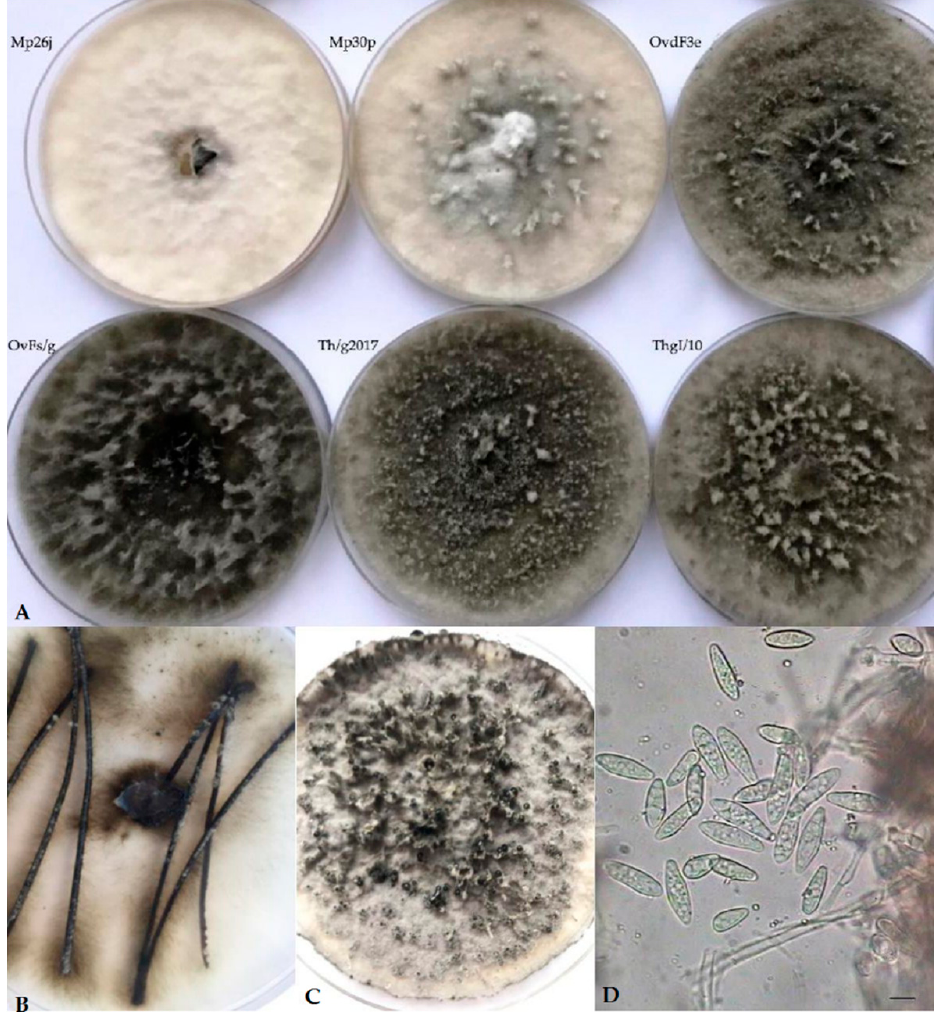
Figure 1. ( A ) Variable morphology of isolates from Asphondylia galls collected in our study. ( B , C ) Production of pycnidia, respectively, on pine needles on WA (water agar) and on PDA (potato dextrose agar). ( D ) Fusicoccum